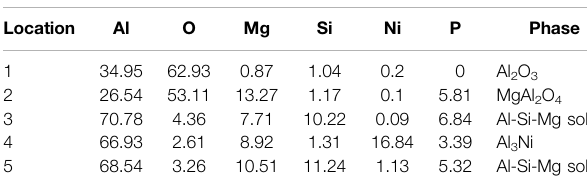
TABLE 2 | EDS scan results of each point in Figure 6